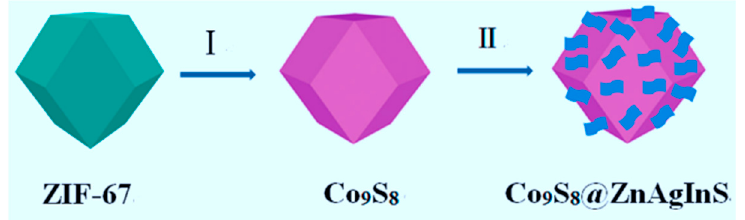
Figure 8. Scheme for hierarchical heterostructured Co 9 S 8 @98ZnAgInS photocatalyst: fabrication through extra situ approach through (I) sulfidation reaction and thermal treatment in a nitrogen atmosphere and (II) deposition of ZnAgInS nanosheets [115].